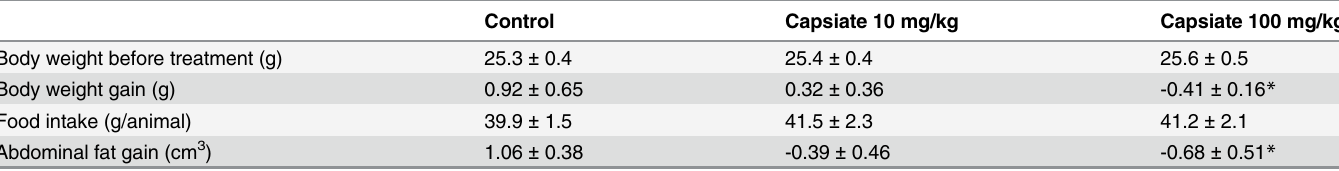
Table 1. Food intake, body weight and abdominal fat gain over 2-week daily administration of vehicle or